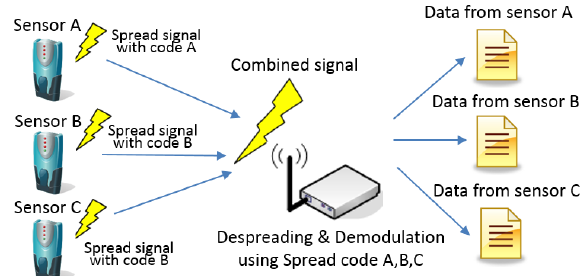
Figure 1. The concept underlying code division multiple access.